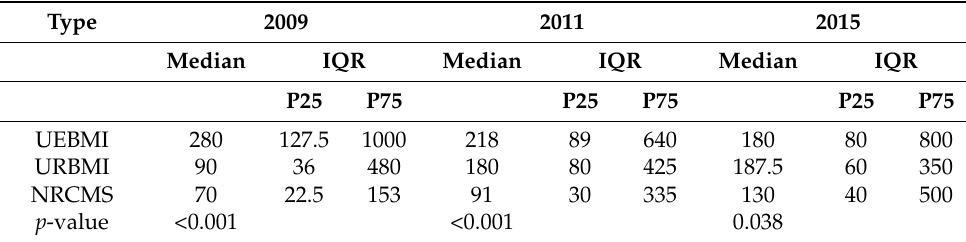
Table 4. Outpatient reimbursement amount by year and social health insurance schemes in China (RMB).